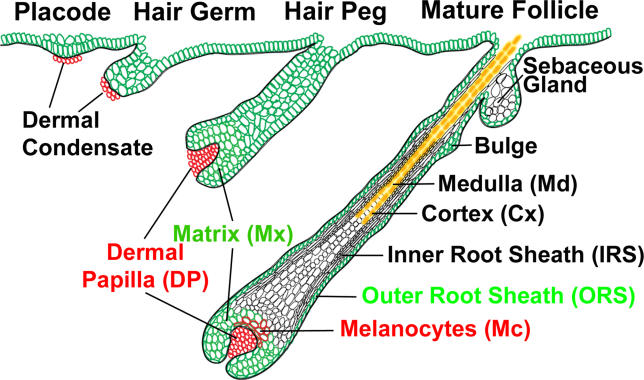
Having identified the molecular signatures of the dermal papilla and its neighboring cells, researchers can now study how these genes influence hair development and growth